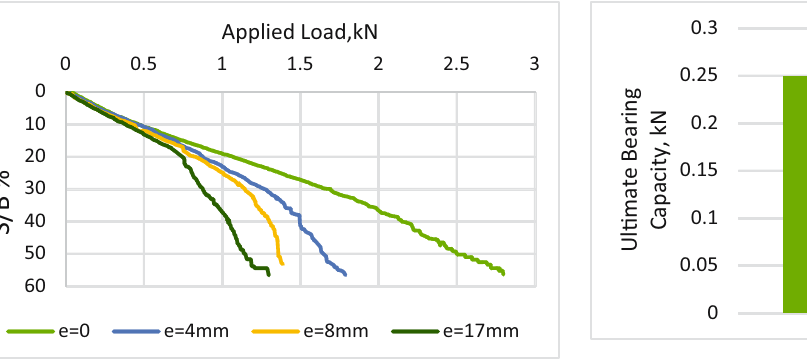
Figure 14: Ultimate bearing load at D s = 0.5 B .